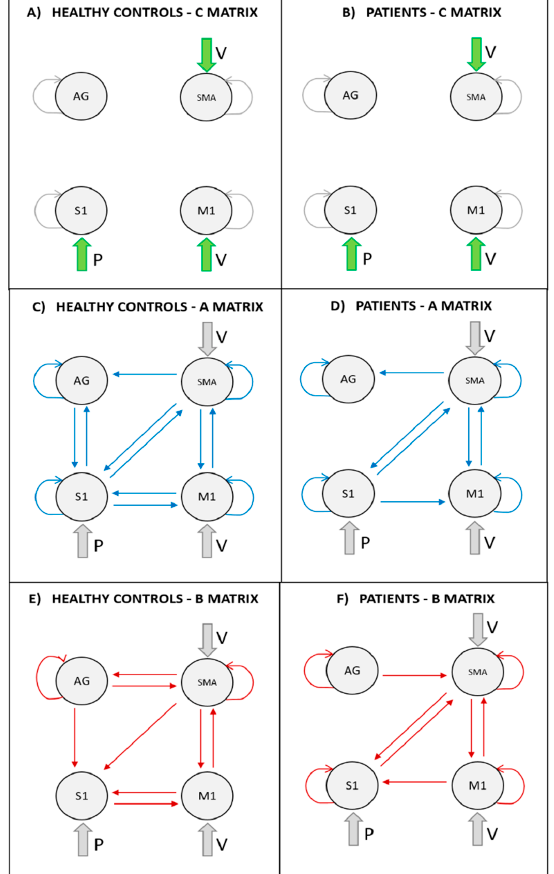
Figure 2. The architecture of the outcome winning model from each methodological STEP. ( A ) STEP 1: winning input matrix (i.e., C matrix) for controls group; ( B ) STEP 4: input matrix for patients group defined as the winning model in STEP 1; ( C ) STEP 2: winning structural matrix (i.e., A matrix) for controls group; ( D ) STEP 5: winning structural matrix for patients group; ( E ) STEP 3: winning bilinear matrix (i.e., B matrix) for controls group; ( F ) STEP 6: winning bilinear matrix for patients group.